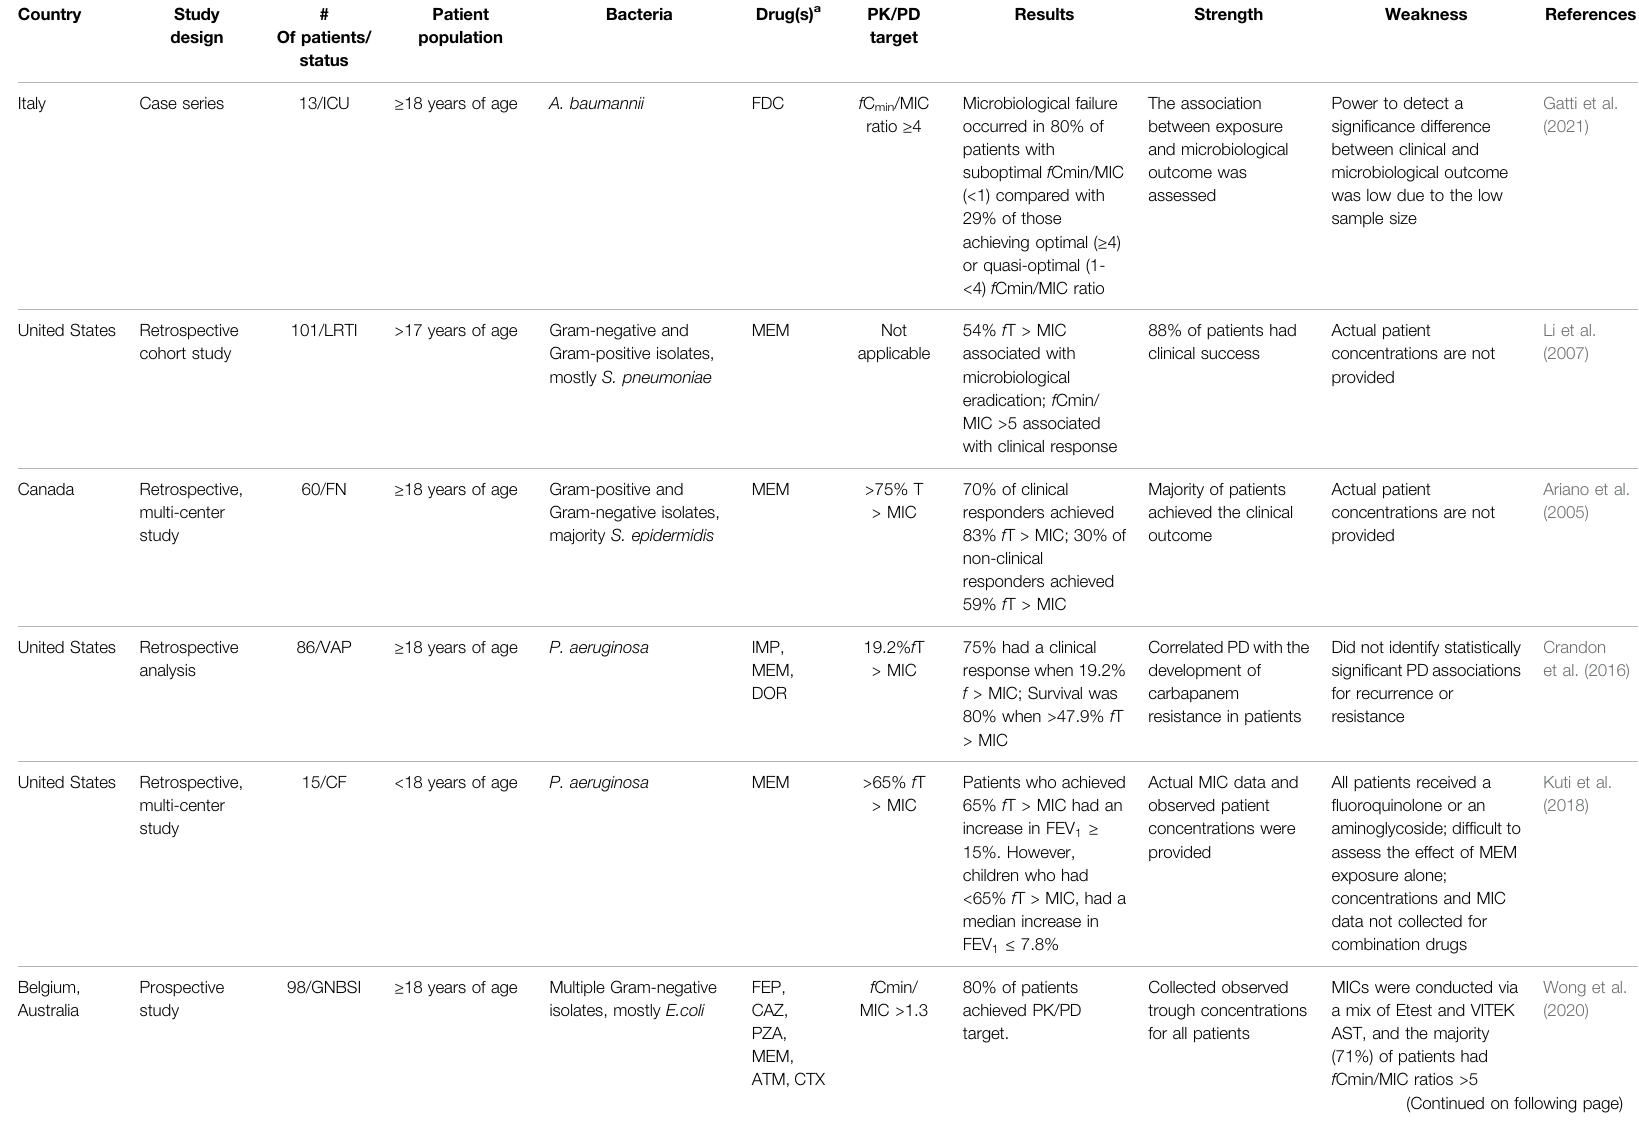
TABLE 1 | ( Continued ) Summary of details for clinical pharmacodynamic studies of